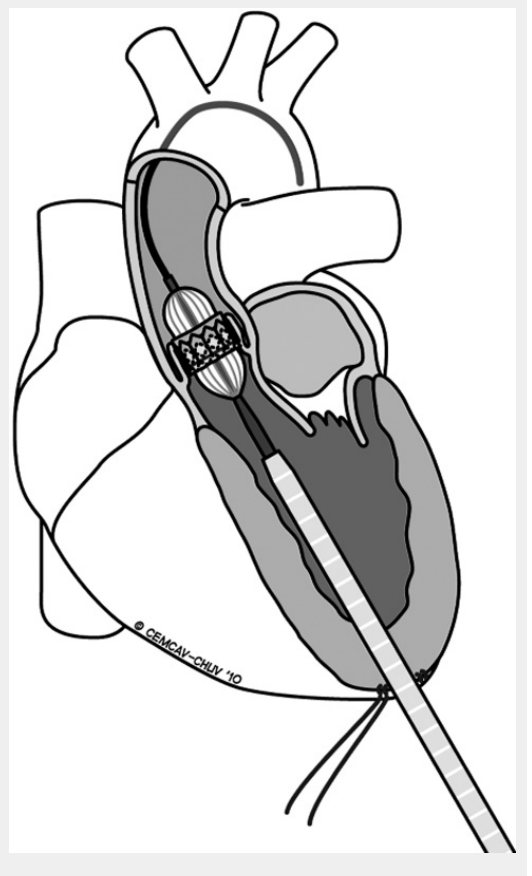
Transfemoral approach for implanting a transcatheter aortic stent-